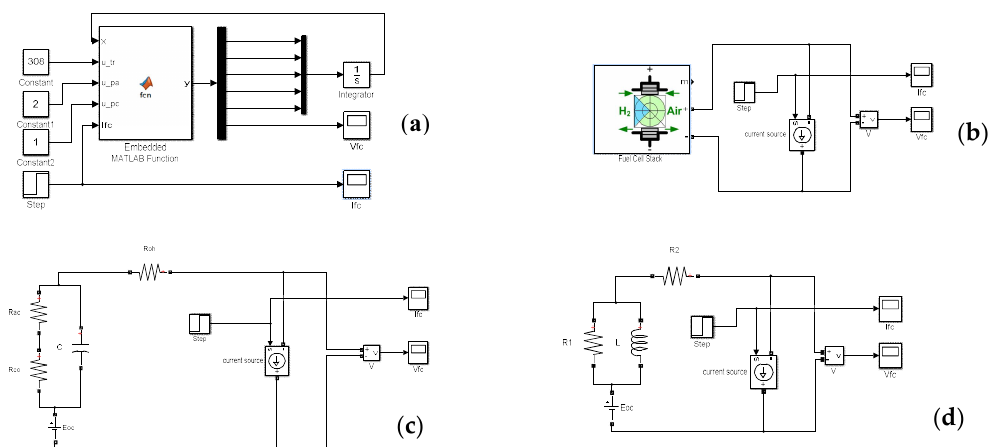
Figure 11. Simulated models in MATLAB/Simulink: ( a ) nonlinear model (NLM); ( b ) generic MATLAB model (GMM); ( c ) RC model (RCM); and ( d ) RL model (RLM). Table 3. Simulation parameters.